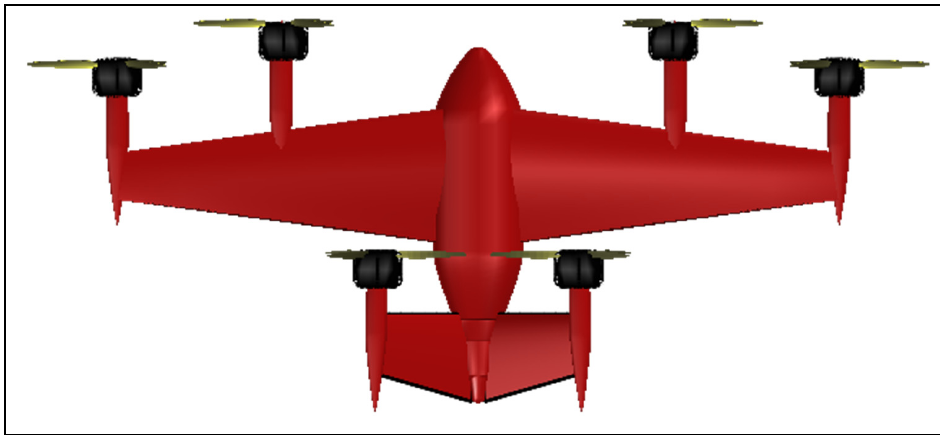
Figure 17. OpenVSP model (top view) with motor locations.